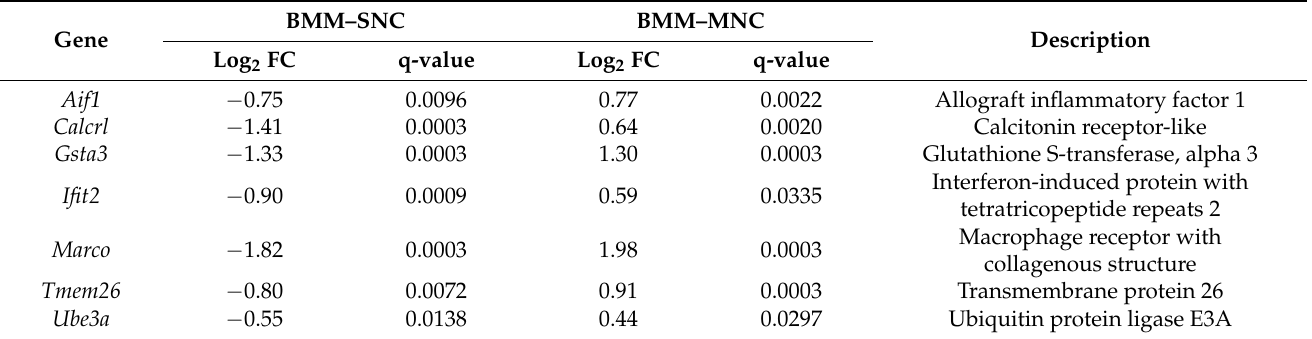
Table 2. Seven DEGs revealed with opposite expression patterns between the BMM-SNC and BMM- MNC